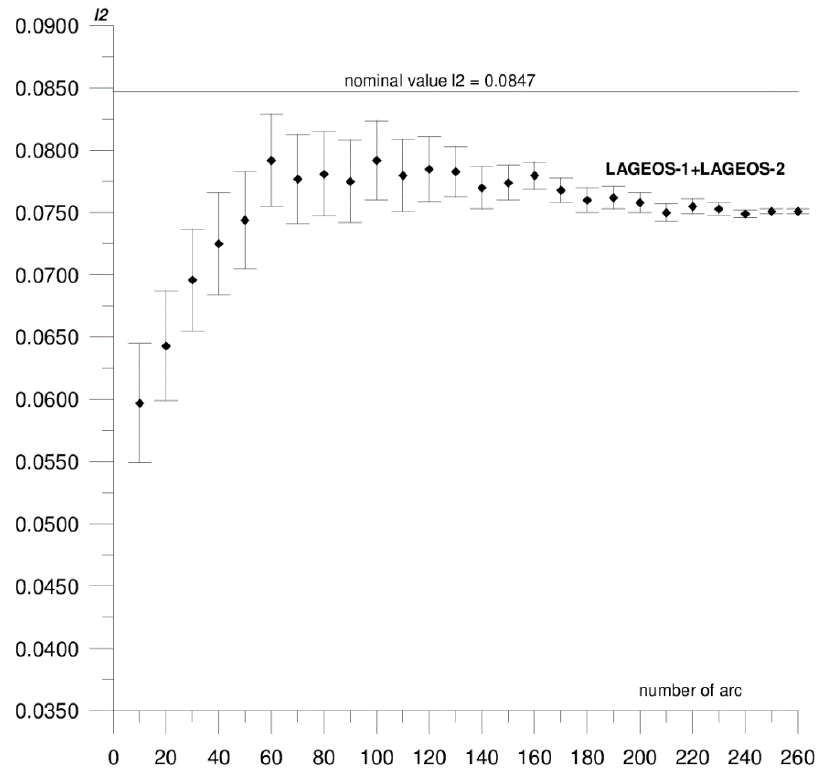
Figure 4. Sequential solution for the Yarragadee local l 2 parameter based on LAGEOS-1+LAGEOS-2 data.